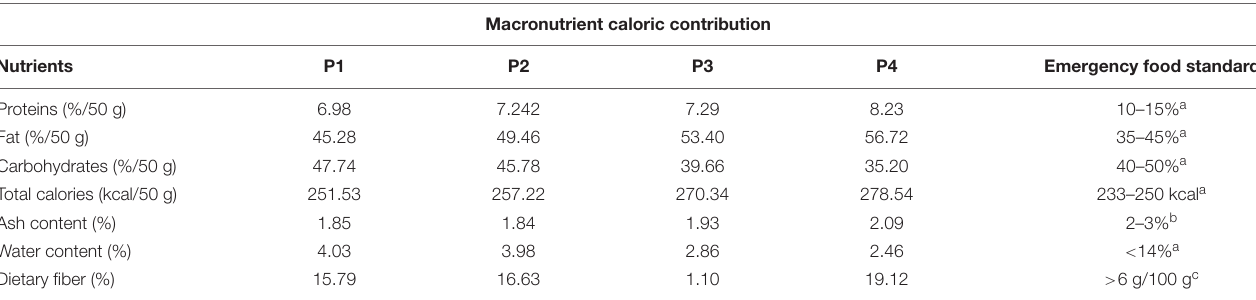
TABLE 3 | Caloric contribution of sagon formulated with lindur and soybean flour.